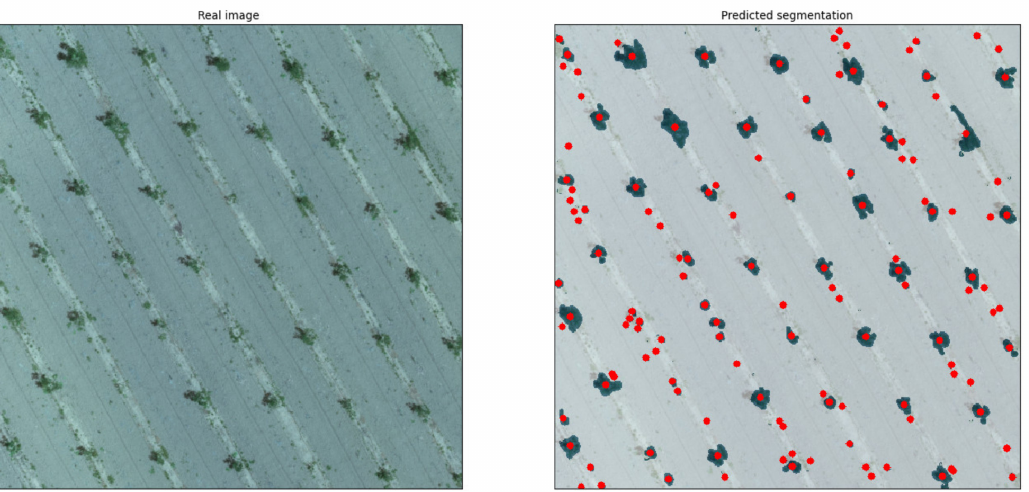
Figure 10. Undersampled orthomosaic of an orchard with small canopies, not treated for weeds ( left ), and the segmentation predicted by the model ( right ).